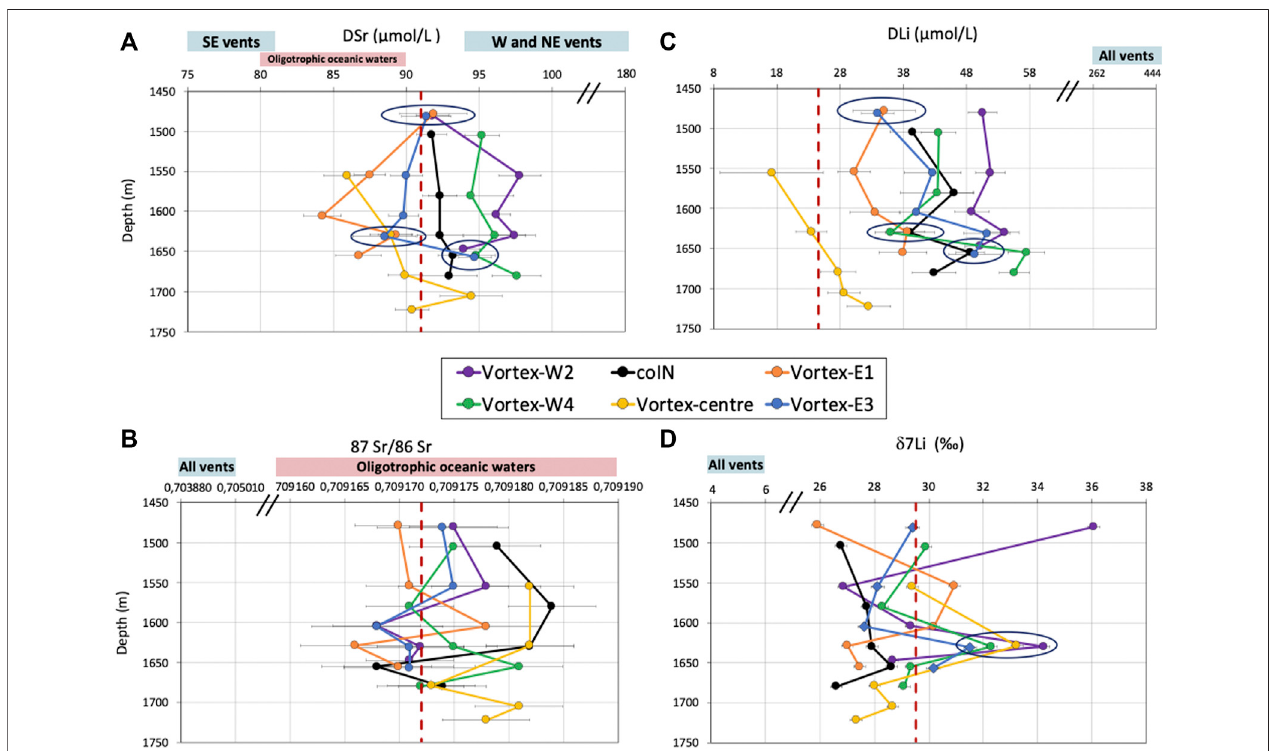
FIGURE 2 | Depth pro fi les of DSr (left panels) and DLi (right panels) elemental and isotopic compositions for the six CTD casts over the Lucky Strike Hydrothermal Field(LSHF). Thedata areallplottedwiththeir respectiveuncertainties. Seawater compositionsareindicated andcorrespondto (A) referenceseawater(red dashed line at91 µmol/L;Milleroetal.,2008),andrangeofoligotrophicoceanicwaters(redboxbetween80and90 µmol/L;ElMeknassietal.,2020), (B) themean(reddashed line) andrange(redbox)ofoligotrophicoceanicwaters(0.709172±0.000023;ElMeknassietal.,2020),and (C,D) IAPSOseawaterstandardcomposition(reddashed line at 24.6 µmol/L; Leleu, 2017; and at 29.5 ‰ , this study). The hydrothermal fl uid composition ranges of the LSHF vents ( Supplementary Table S2 ) are indicated by the light blue boxes with the vent locations speci fi ed inside (SE = South East, W = West, NE = North East, All vents). Samples with identical elemental and/or isotopic compositions are